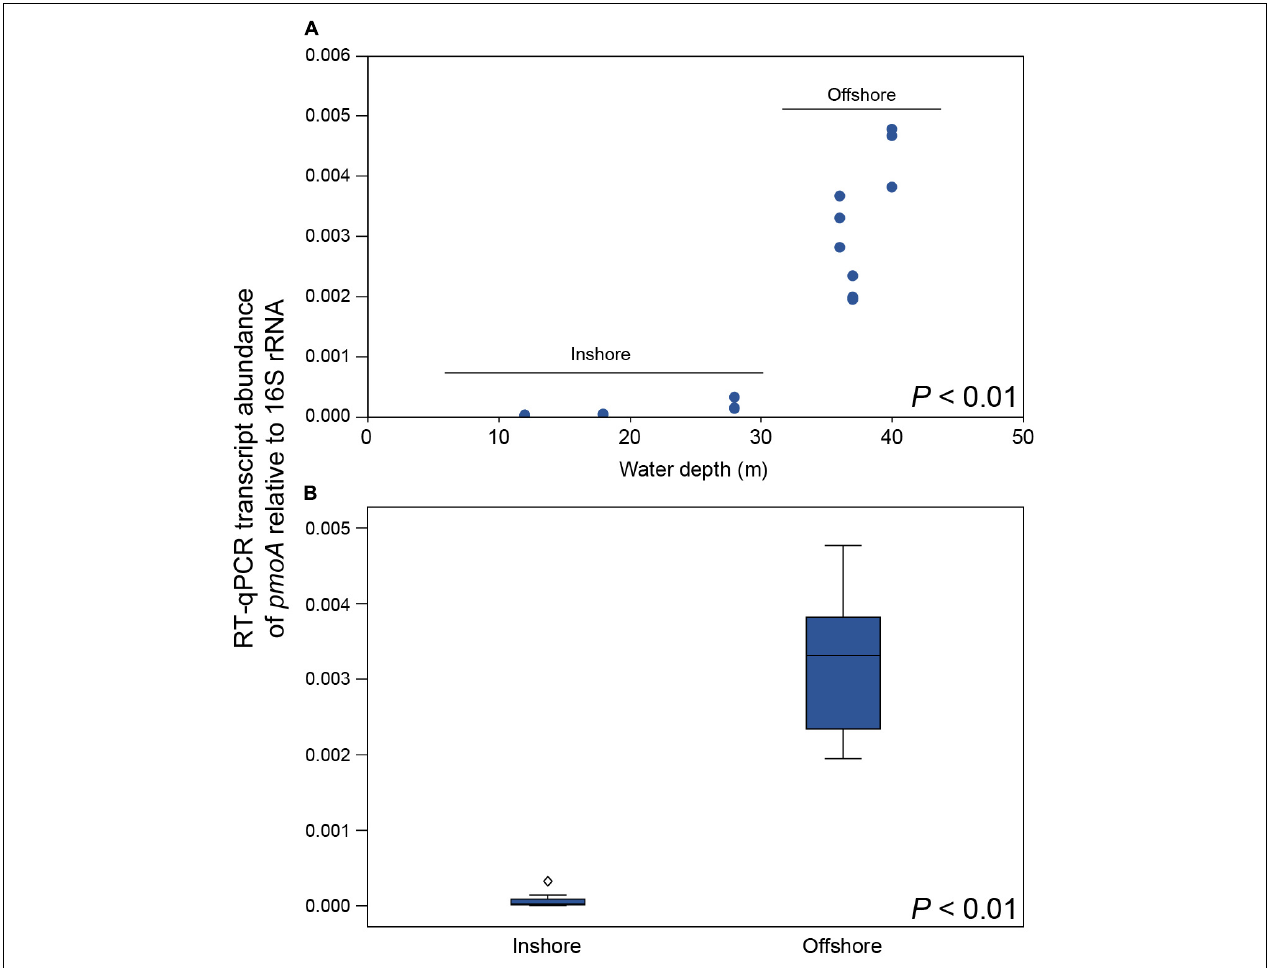
FIGURE 4 | (A) RT-qPCR results showing the number of pmoA RNA transcripts relative to 16S rRNA for each station along the water depth gradient ( y -axis shows NRQ; normalized relative quantification). (B) Boxplot graph showing the inshore stations compared to the offshore stations. The diamond symbol denotes an outlier 3 or more box lengths from the median. The P -values indicate the statistical significance (One-Way ANOVA) between inshore and